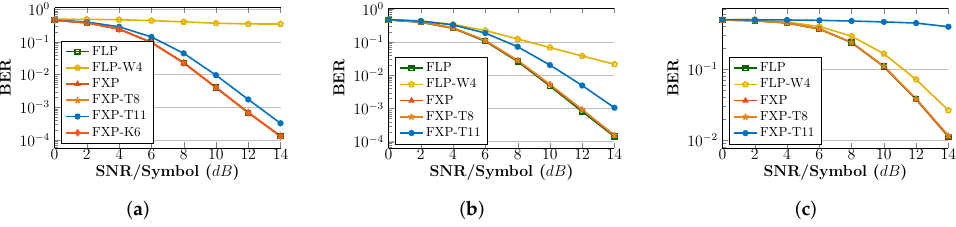
Figure 6. BER scaling in our 64-QAM circuits. FLP = accurate floating-point, FLP-W4 = floating- point with approximate addition [19], FXP = accurate fixed-point, FXP-T X = fixed-point with bit truncation, FXP-K6 = fixed-point with approximate multiplication [14]. ( a ) Approximate LLR (ALLR). ( b ) Piecewise LLR (PLLR). ( c ) Approximate ML (AML).